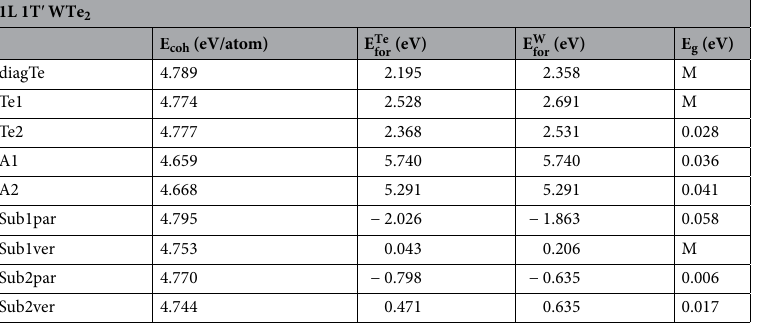
Table 3. Cohesive energy ( E coh ) per atom, formation energy calculated in Te-rich environment ( E Te for ) and in W-rich environment ( E W for ), electronic energy band gap ( E g ) values calculated for defective structures of 1L 1 T ′ WTe 2 . Abbreviations used in the first column of the table are as follows: diagTe, diagonal Te vacancy; Te1, Te(1) vacancy; Te2, Te(2) vacancy; A1, Te(1)-W antisite; A2, Te(2)-W antisite; Sub1par, Te(1)- O 2 substitution with parallel orientation; Sub1ver, Te(1)- O 2 substitution with vertical orientation; Sub2par, Te(2)- O 2 substitution with parallel orientation; Sub2ver, Te(2)- O 2 substitution with vertical orientation. Note that, M denotes the metallic case, in which some of the electronic bands cross the Fermi energy ( E F